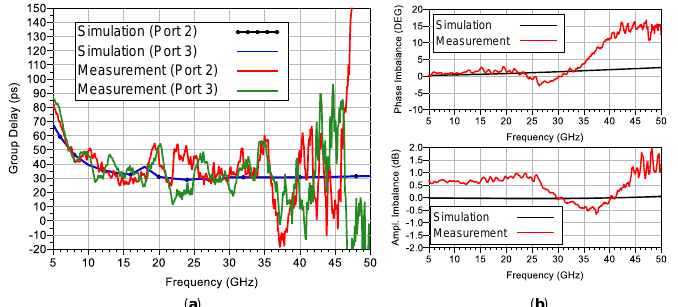
Figure 8. Small signal TIA measurements: ( a ) simulated and measured group delay response for each of the differential TIA outputs (ports 2 and 3); ( b ) amplitude and phase imbalance (deviation from out-of-phase condition) between the two TIA